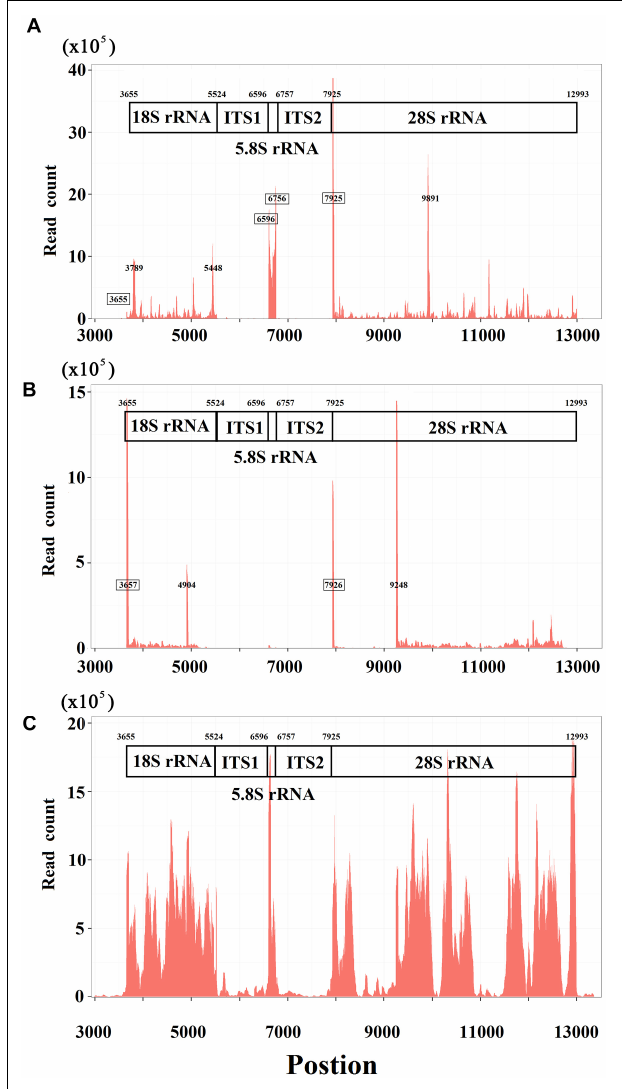
FIGURE 2 | Genome-alignment maps using sRNA-seq, Cage-seq, and GRO-seq. This figure shows the count distribution of all aligned reads on the reference rRNA sequence (RefSeq: NR_046235.1). These reads are from one sRNA-seq dataset (A) one CAGE-seq dataset (B) and one GRO-seq dataset (C) the description of these datasets can be seen in the Section “Materials and Methods.” The identified 5 (cid:48) and 3 (cid:48) ends of mature RNAs are marked by boxes.